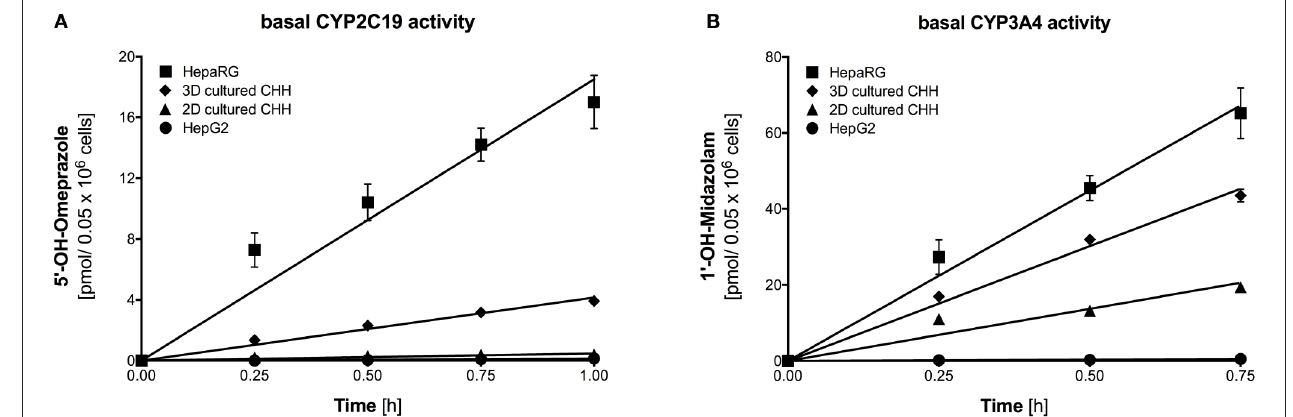
FIGURE 2 | Basal activity of CYP2C19 and CYP3A4 assessed using formation rates of 5-hydroxyomeprazole (A) and 1 ′ -hydroxymidazolam (B) in HepG2, HepaRG, 2D-, and 3D-cultured primary cryopreserved human hepatocytes. Primary hepatocytes were from the same batch of cryopreserved cells. Metabolite concentrations were determined by LC-MS/MS. The corresponding velocities and regressions are given in Table 2 . Data are presented as mean ± SEM of at least three independent experiments. PHH, primary human